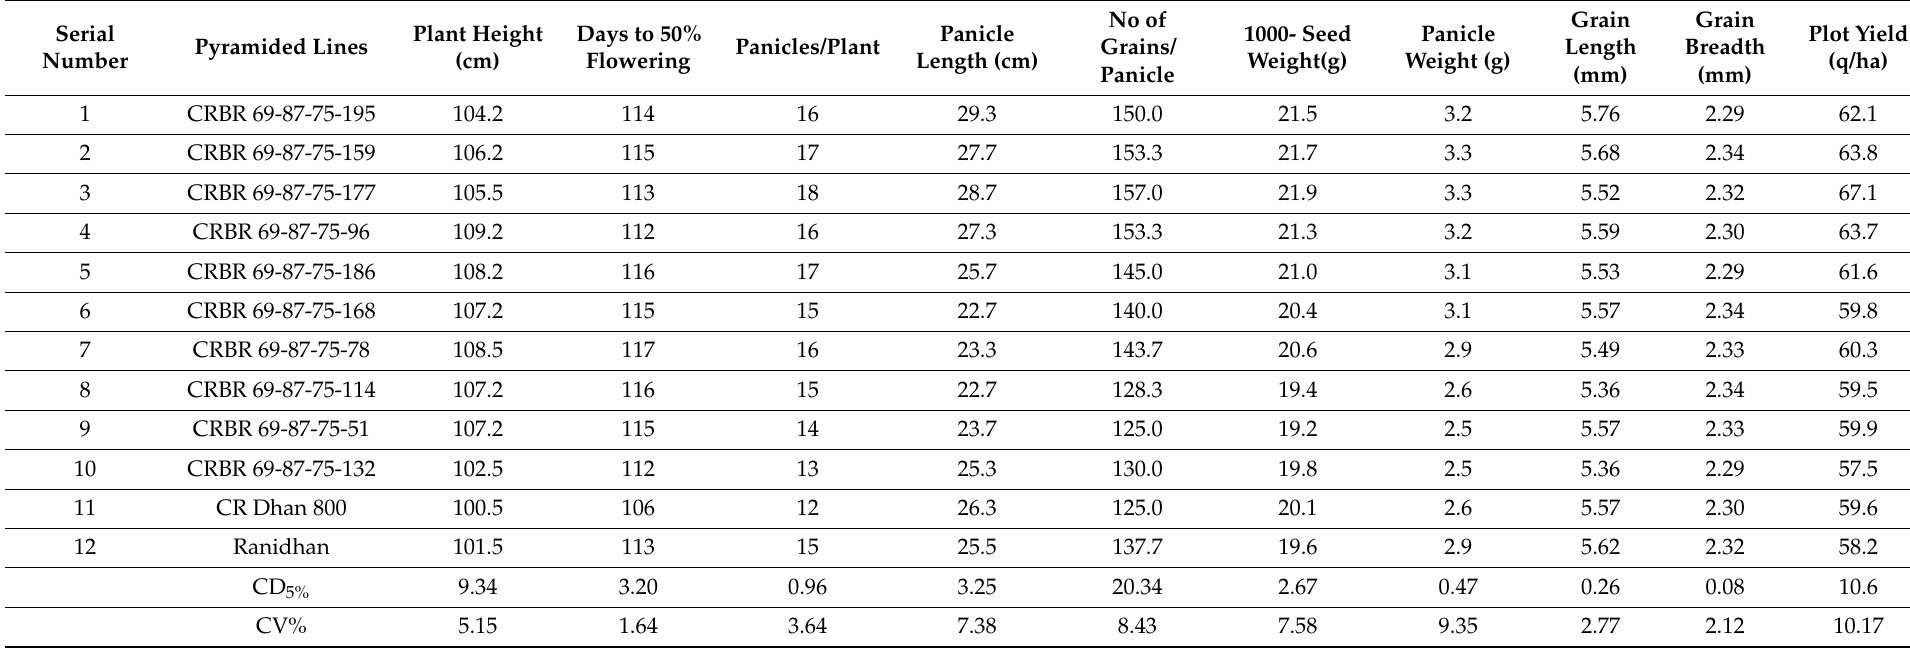
Table 3. Grain yield, agro-morphologic and grain quality traits of parental and selected BC 3 F 3 and BC 3 F 4 pyramided